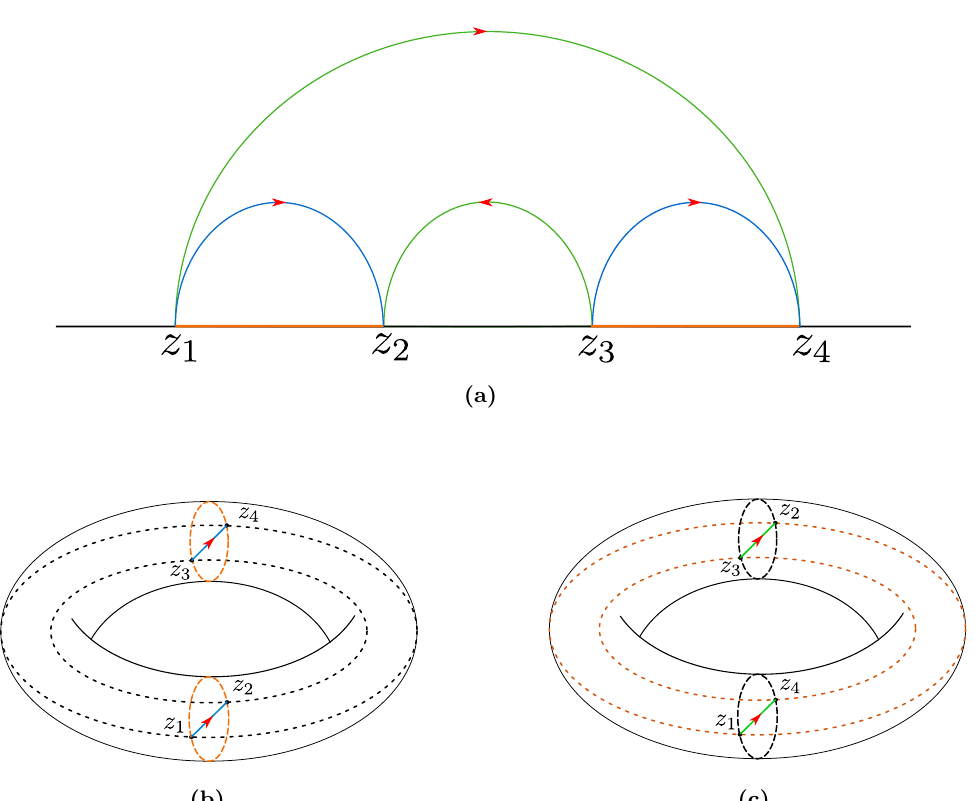
Figure 2. (a) Shows the two different configurations of the Wilson lines in the bulk replica n -fold, where the blue and green lines are the Wilson lines dual to the s -channel and t -channel of the four point function of charged twist operators, respectively. The red arrows indicate the direction of the field strength. (b) and (c) show the bulk constructions in the universal covering of the replica 2 -fold corresponding to s -channel and t -channel, respectively. In each phase, the Wilson lines always follow the locus of the Z 2 fixed points of the torus, which are the geodesics with minimal length. The branch cuts are represented by the orange lines, which are contractible circles in the s -channel and non-contractible in the t